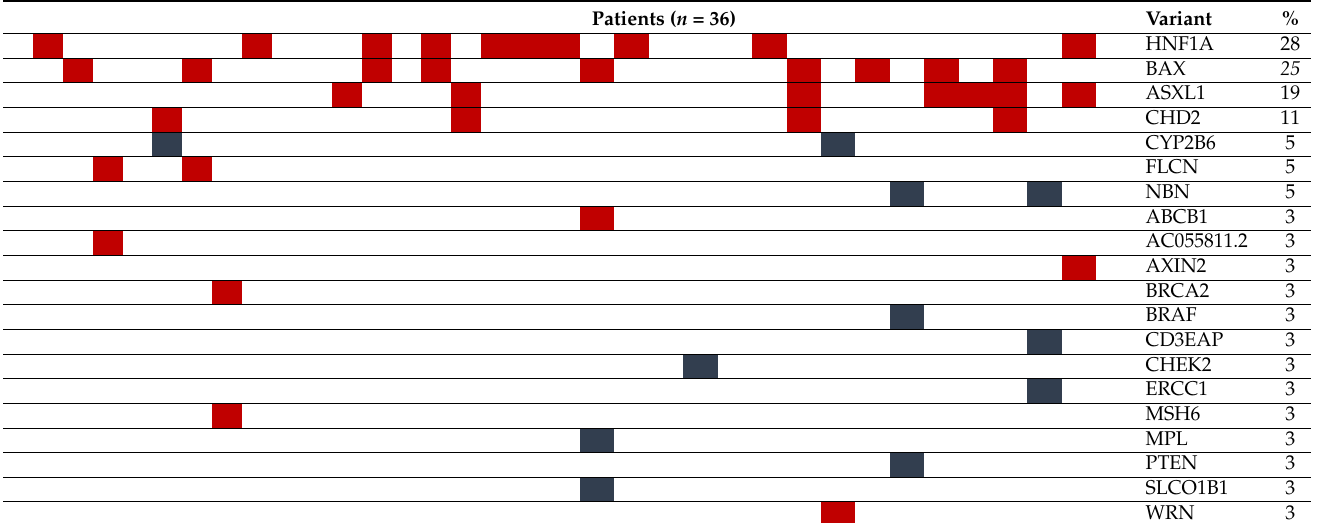
Table 3. Molecular profiles of cfDNA in liver cirrhosis (LC) patients. Single nucleotide variant (SNV) (in red) and insertions and deletions (InDels) (in blue) are shown in descending order with respect to the mutation recurrence rate. Patients ( n = 36)